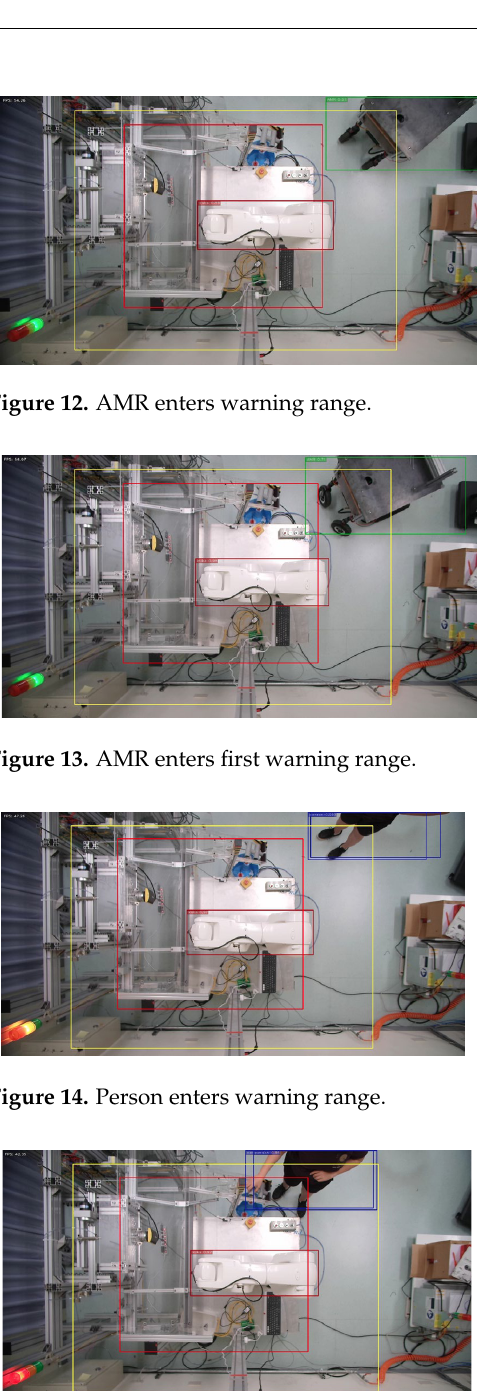
Figure 15. Person enters dangerous range.